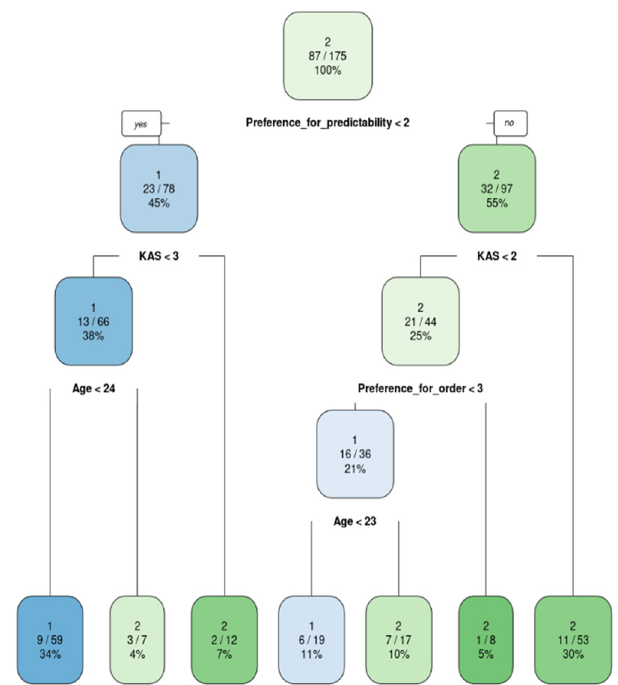
Figure 2. Classification model for a stay in the cultural facilities: 1—wearing a mask; 2—not wearing a mask.